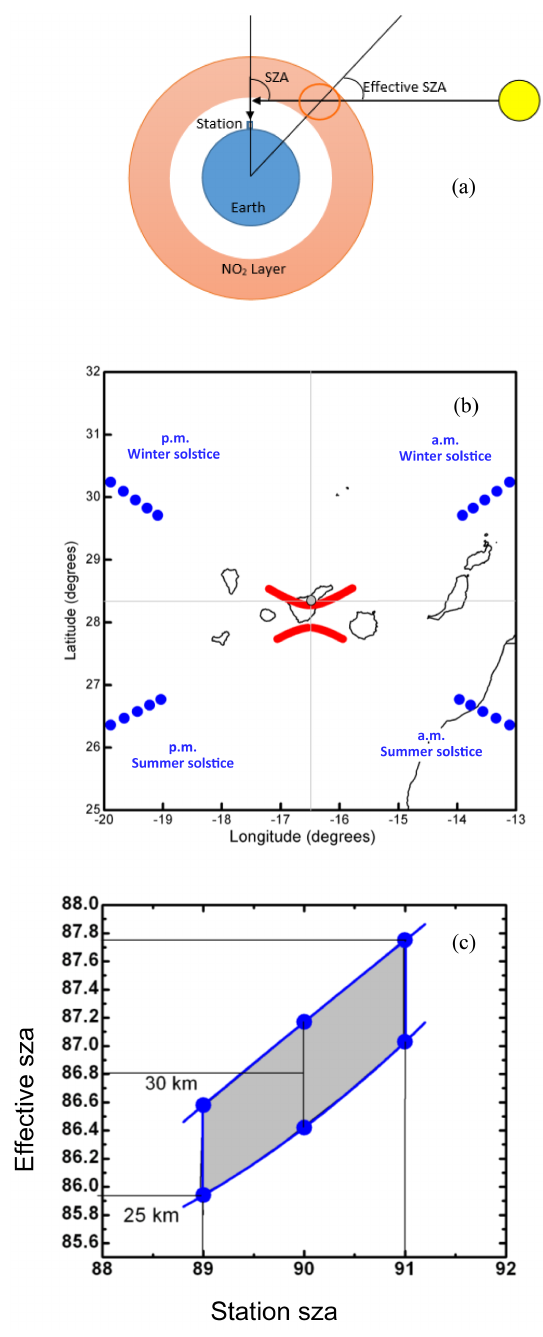
Figure 2. Representation of the effective NO 2 air mass (a) scanned by the DOAS instrument. (b) Surface projection of scanned air masses for FTIR (red) and DOAS (blue) instruments for winter and summer solstices. Calculation assumes the bulk of the NO 2 layer at 30km height. (c) Effective solar zenith angles vs. local zenith angle for 25 and 30km NO 2 bulk